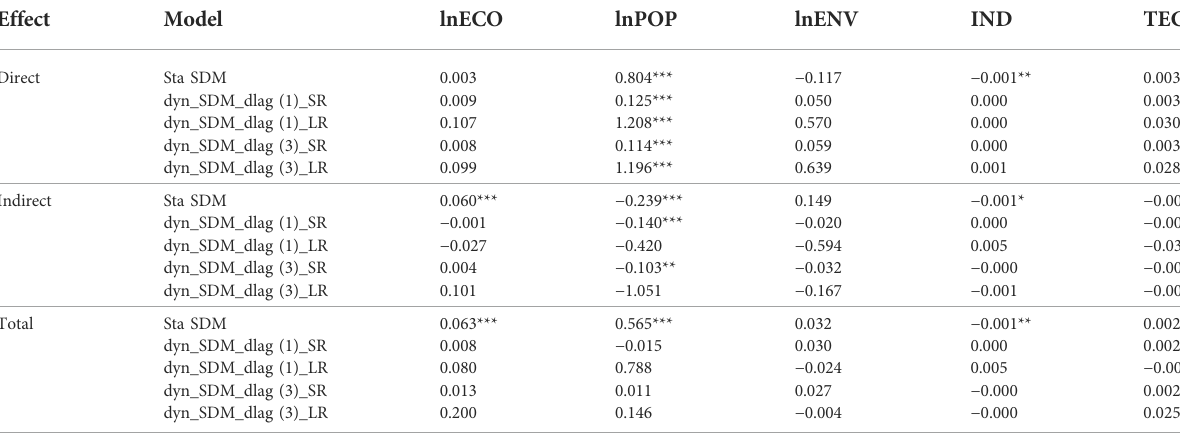
TABLE 5 Estimates of the decomposition of the outcome effects of the Dubin